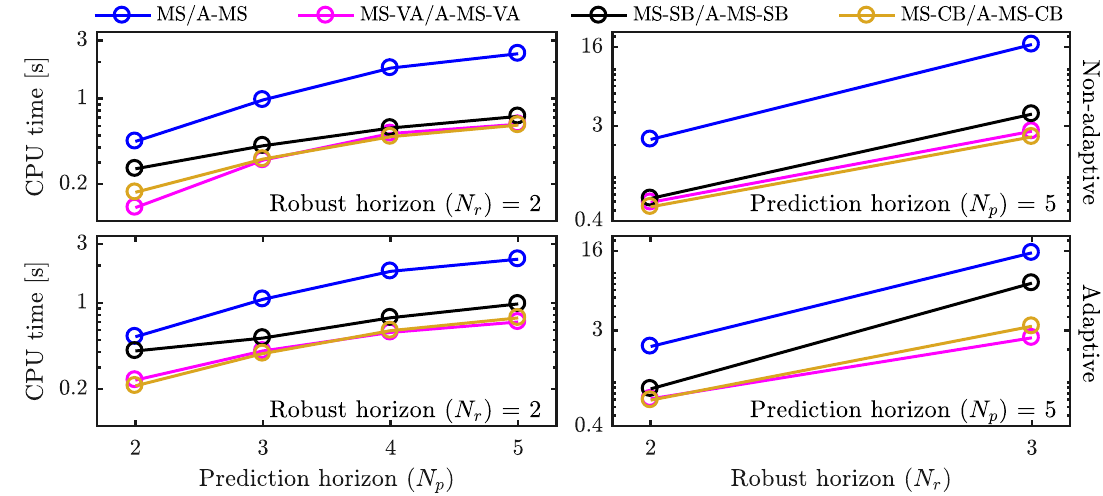
Figure 10. Semi-log plots of the average computation time taken per iteration [in [ s ] ] by the different NMPC schemes for different values of the prediction horizon and robust